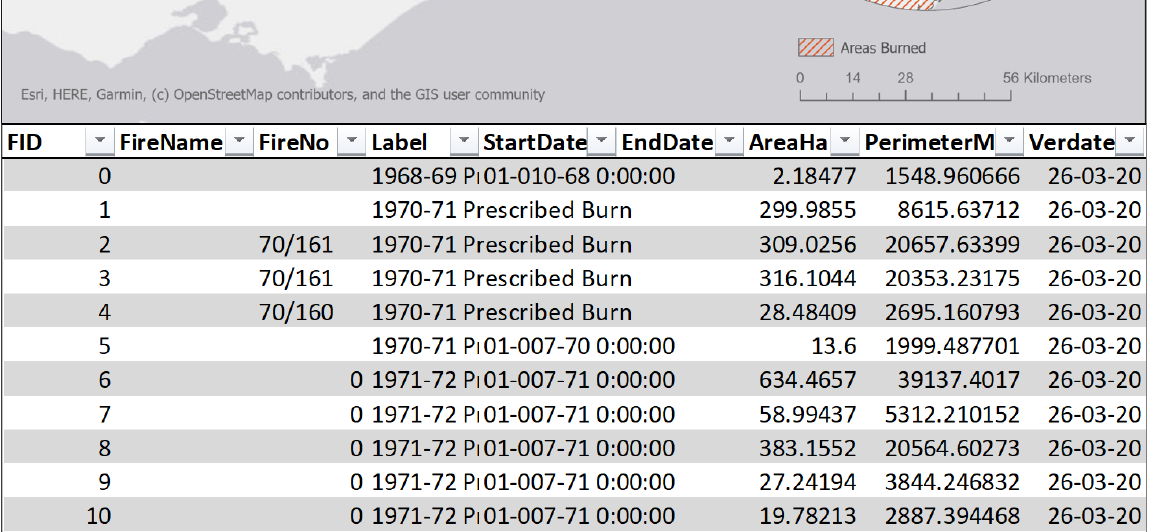
Figure 2. The shapefile data and the attribute table of bushfire over 100 years, visualised in ArcGIS Pro.